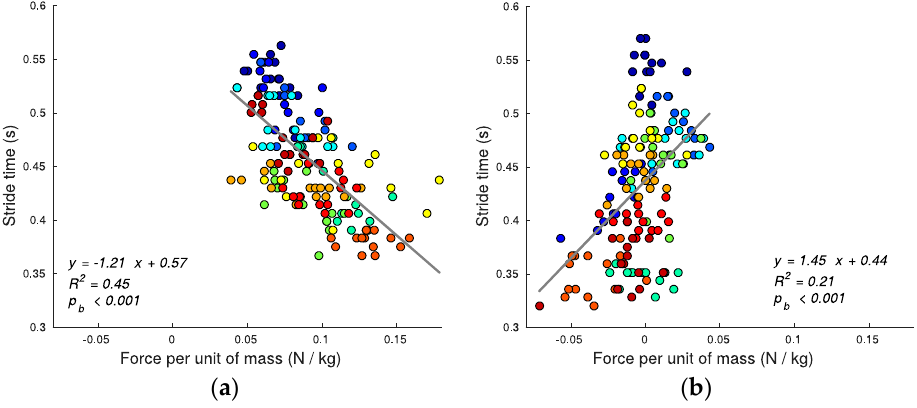
Figure 12. Vertical ground reaction force per unit of mass gfm and stride time t stride relationship for ascending ( a ) and descending ( b ) stairs. Stair ascent employs significantly larger impulses relative to descent.